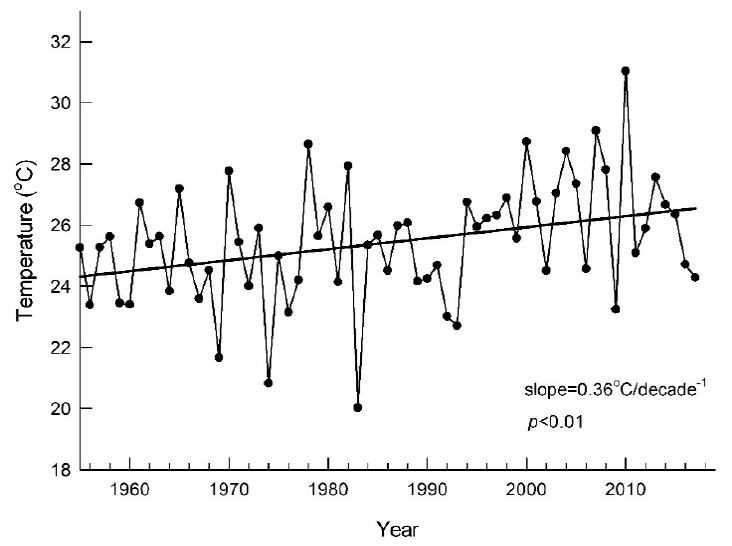
Figure 7. Time series of current June maximum temperature. The heavy line is a trend line with a slop of 0.36 °C/decade ( p < 0.01).